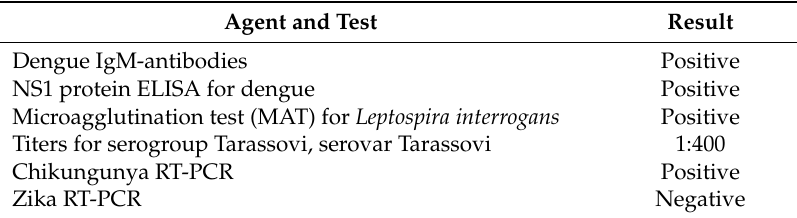
Table 2. Patient infection laboratory